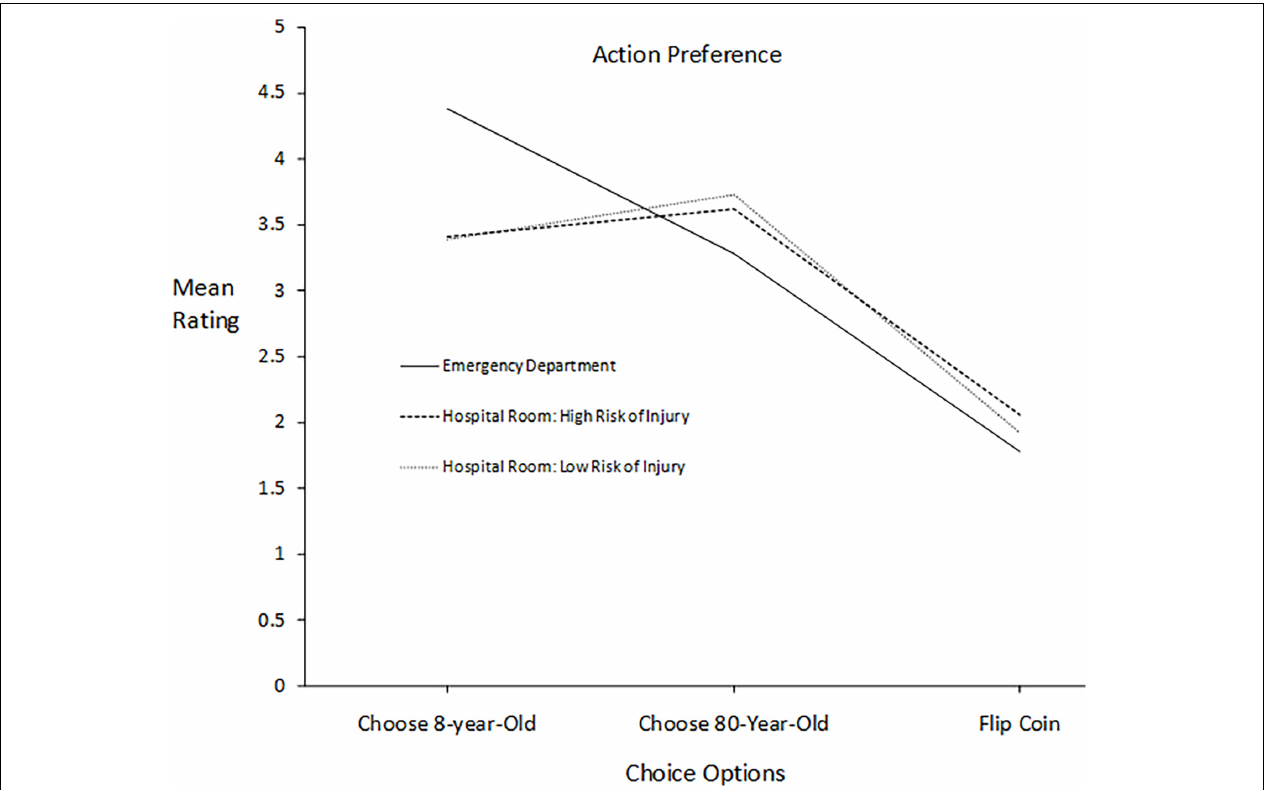
FIGURE 2 | For patients differing in age, participants’ mean ratings of three courses of action in three settings differing in severity of risk to the patients: death, high risk of injury, and lower risk of injury.